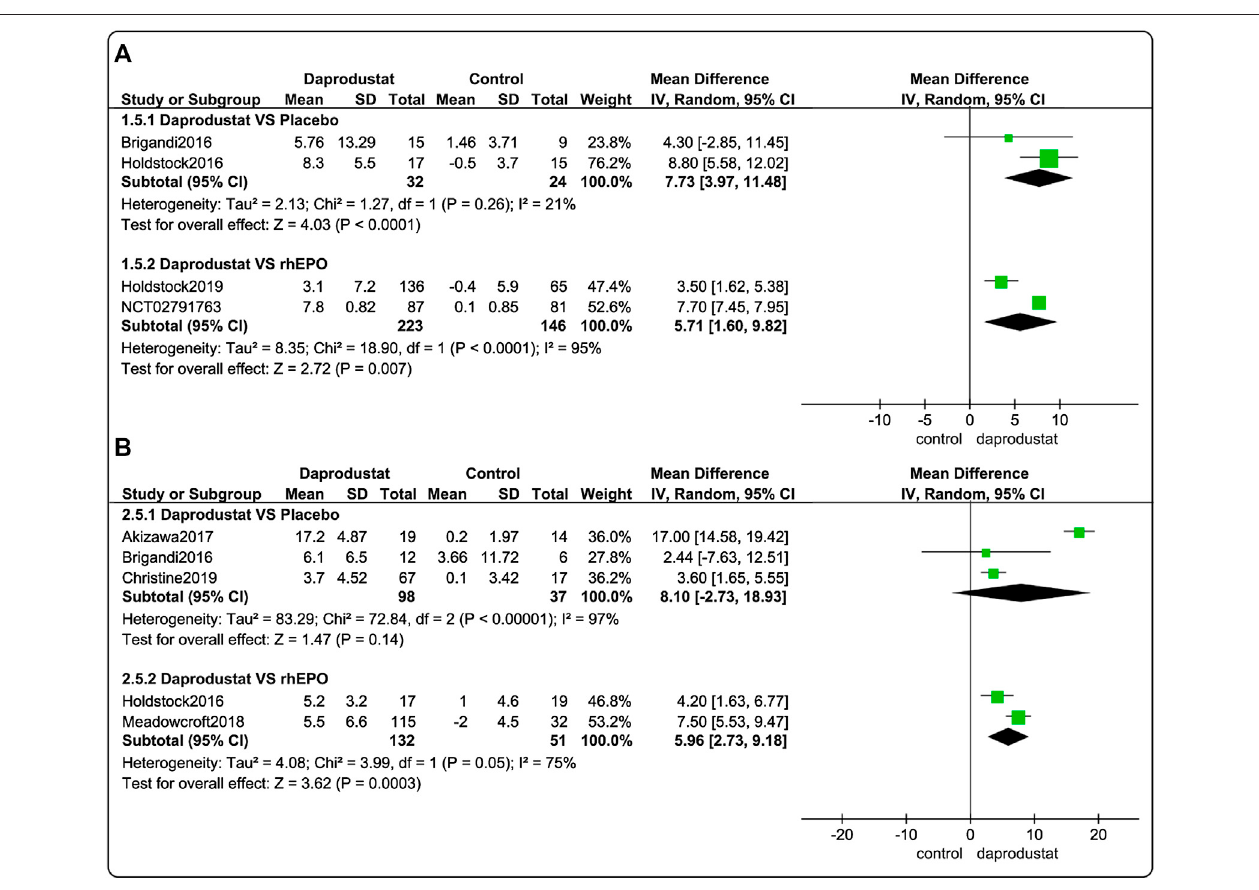
FIGURE 6 | The meta-analysis results of daprodustat for △ TIBC. (A) The pooled results for NDD patients; (B) The pooled results for DD patients.